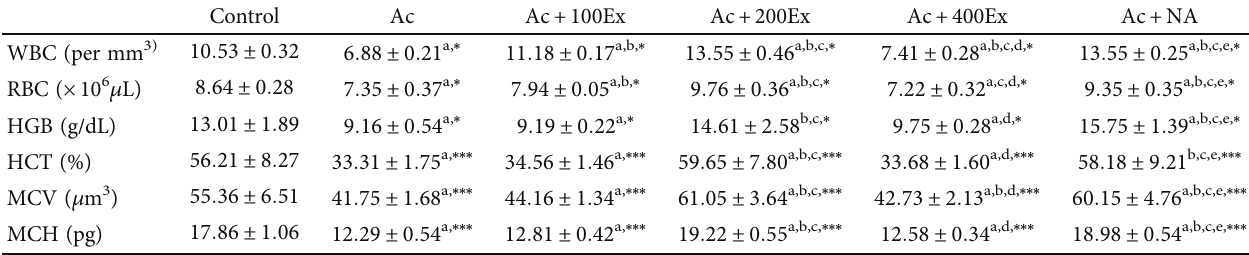
Mean ± SEM of parameters in di ff erent groups. a,b,c,d,e Compared to the control, Ac, Ac+100Ex, Ac+200Ex, Ac+400Ex, and Ac+NA groups, respectively; * P < 0 : 05 . Table 2: Changes in hematological variables of animals in the studied